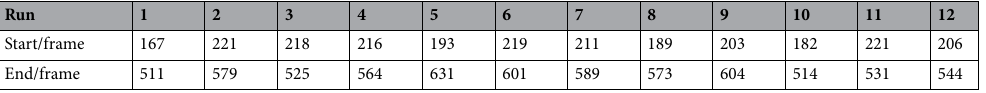
Table 2. Time range of congested state in each run. FPS = 25 frame/s. Note that the congested state is applied in “Density profiles” and “Velocity profiles” sections.